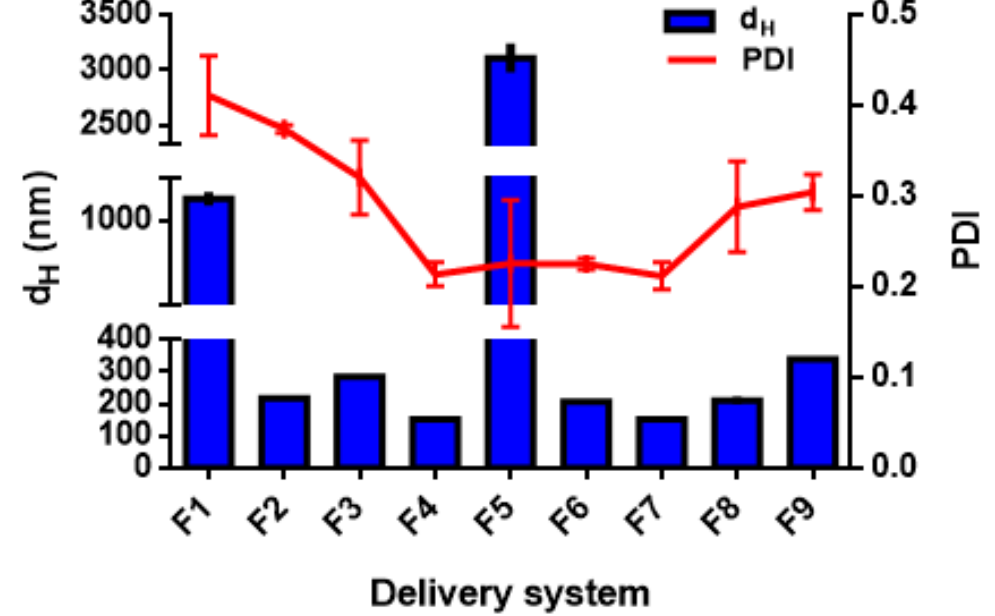
Figure 1. Hydrodynamic diameter (d H ) and polydispersity index (PDI) of TC1 EO nano-emulsions (formulations F1–F9 in Table 1).